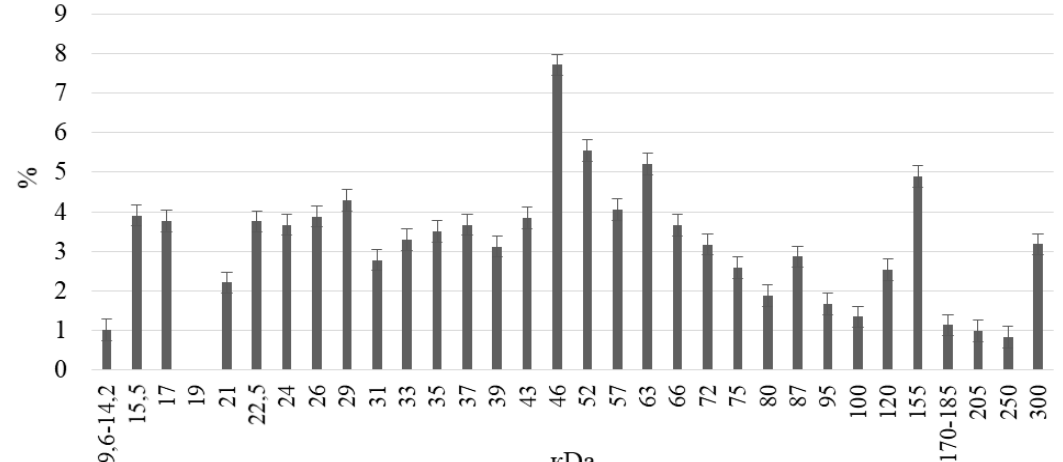
Fig. 2. Structural proteins of the apical membrane of the jejunum enterocytes of eight-month-old cattle fetus (M ± m; %; n = 6)